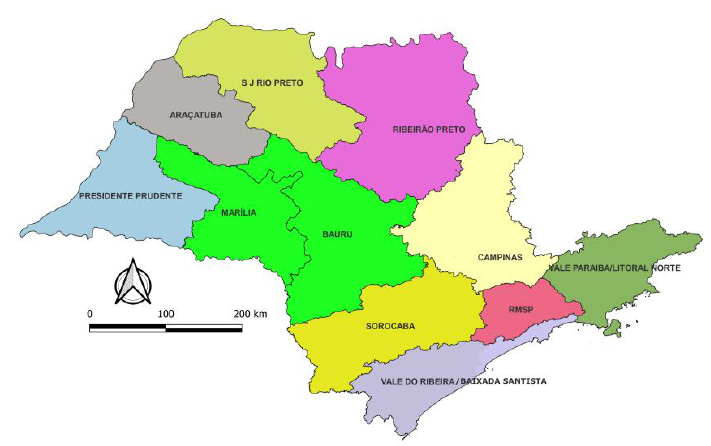
Figure 5. Administrative regions of the state of S ã o Paulo, Figure 5 . Administrative regions of the state of São Paulo, Brazil.